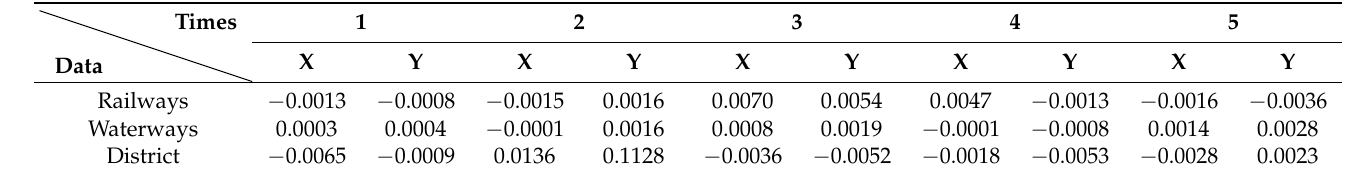
Table 2. The correlation coefficient of different scrambling times.